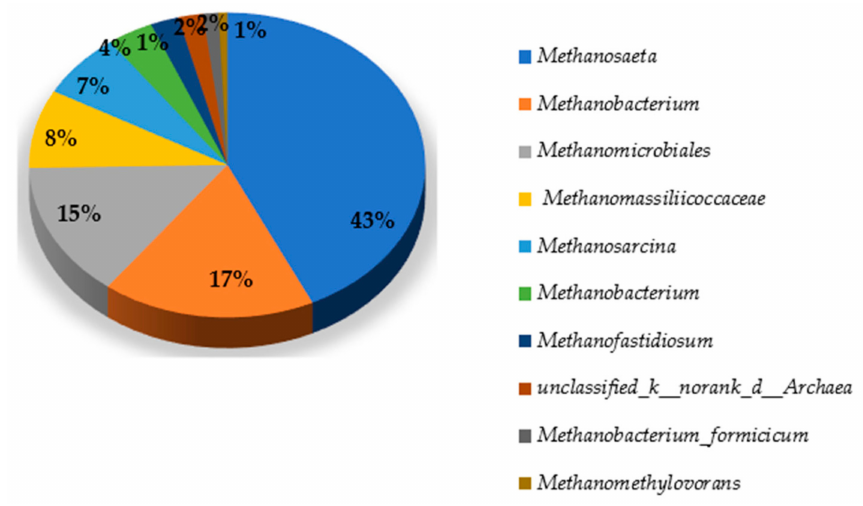
Figure 3. The cake layer archaeal diversity in Genus